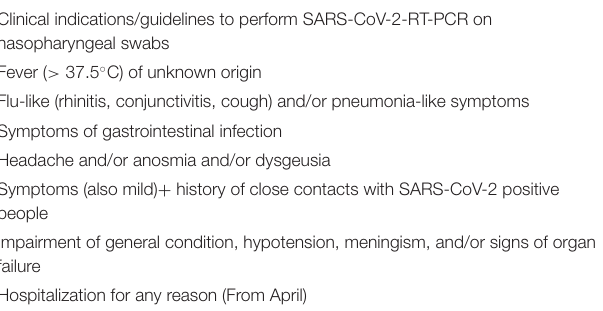
TABLE 1 | Clinical indications/guidelines to perform SARS-CoV-2-RT-PCR on nasopharyngeal swabs. Fever ( > 37.5 ◦ C) of unknown